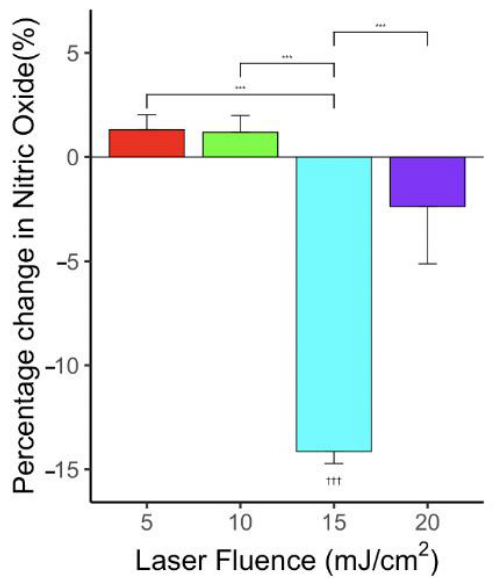
Figure 6. Effect of PUT on NO levels for various laser fluences—5, 10, 15, and 20 mJ/cm 2 —applied synchronously with ultrasound = 0.5 MPa showing significant change in NO levels compared to control. n = 6 for each group. “***” indicates statistical significance between groups with p < 0.001. “†††” indicates statistical significance between control and treatment group p < 0.001.